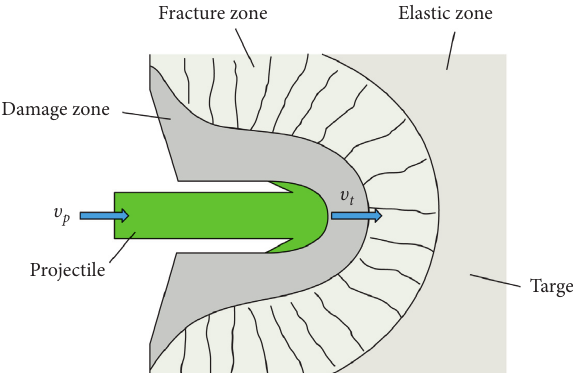
Figure 7: Schematic diagram of the projectile penetrating the